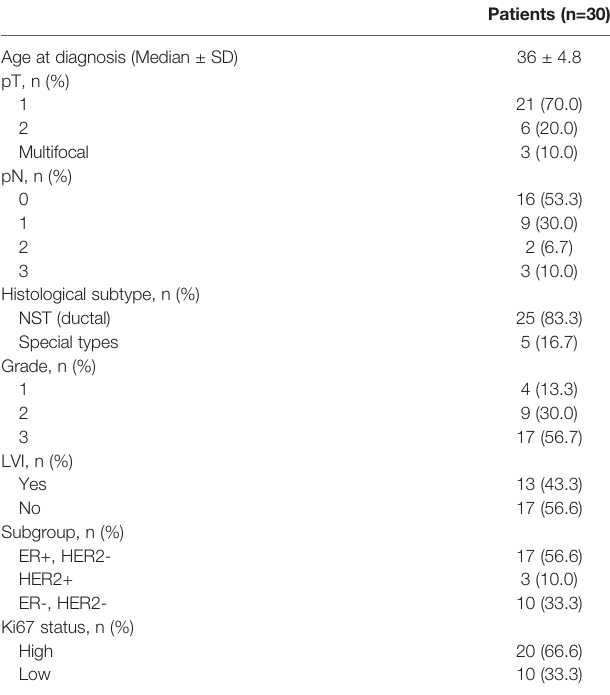
TABLE 1 | Clinicopathologic features of the patients included in this